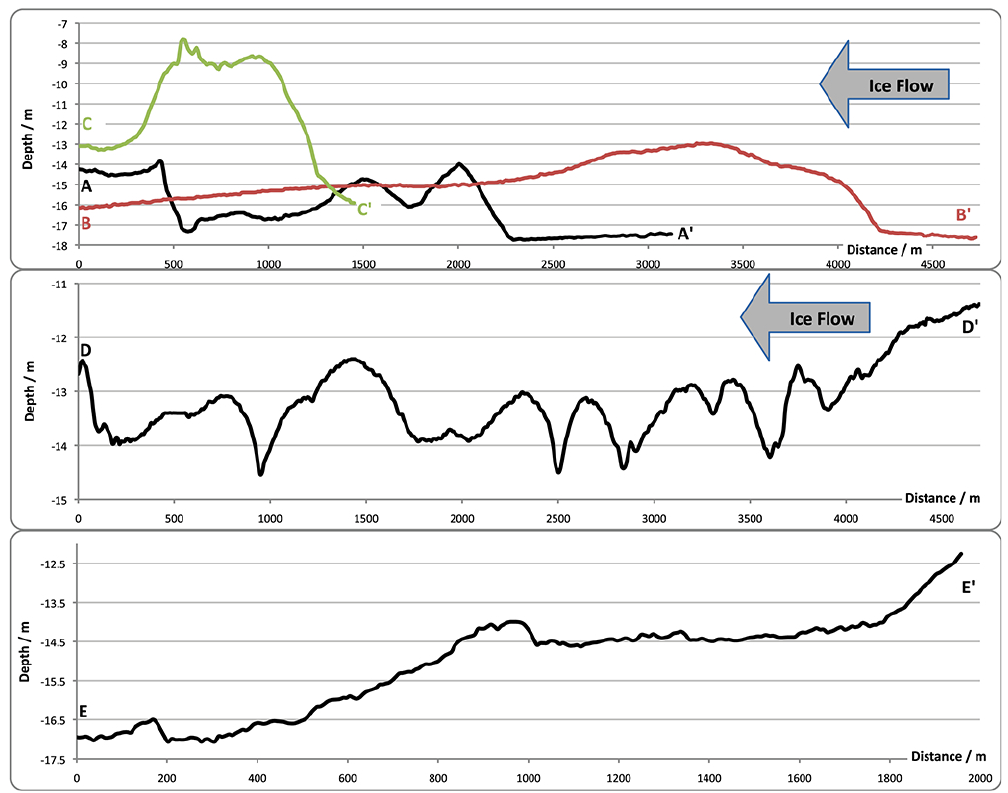
Figure 3. Vertical transects across landforms visible on the seabed of Tremadog Bay, taken from Fig. 2a. Landforms are interpreted as (A–A 0 ) glaciotectonic push moraines, (B–B 0 ) streamlined bedforms, (C–C 0 ) frontal dump moraine, (D–D 0 ) transverse profile of the gullies on Sarn Badrig, and (E–E 0 ) along-profile of one